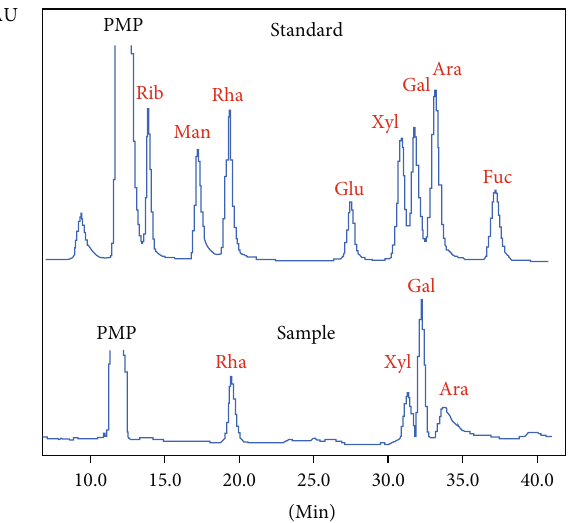
Figure 1: HPLC analysis of MCPs monosaccharide